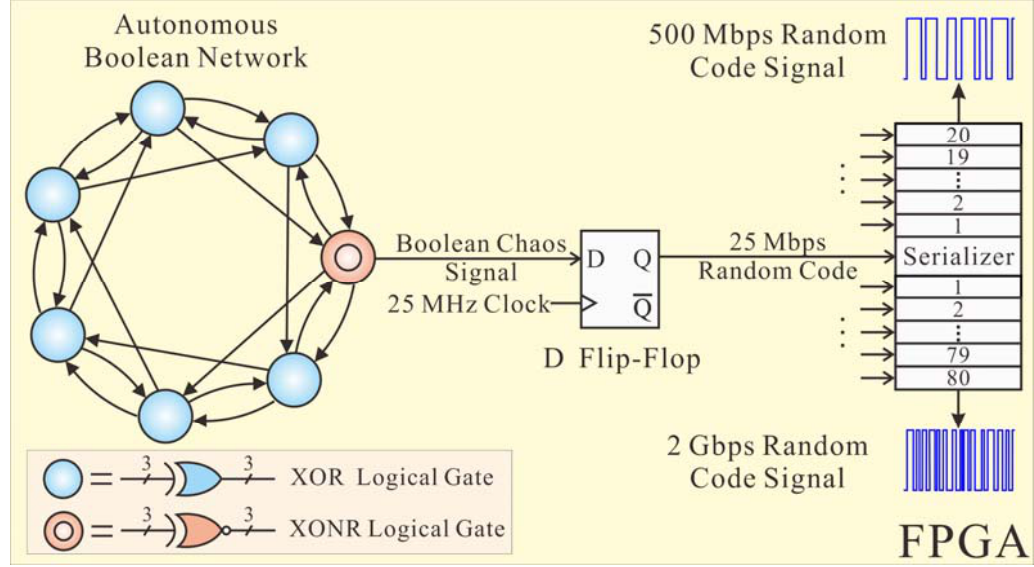
Figure 3. Generation method of the 500 Mbps and 2 Gbps random code signals.